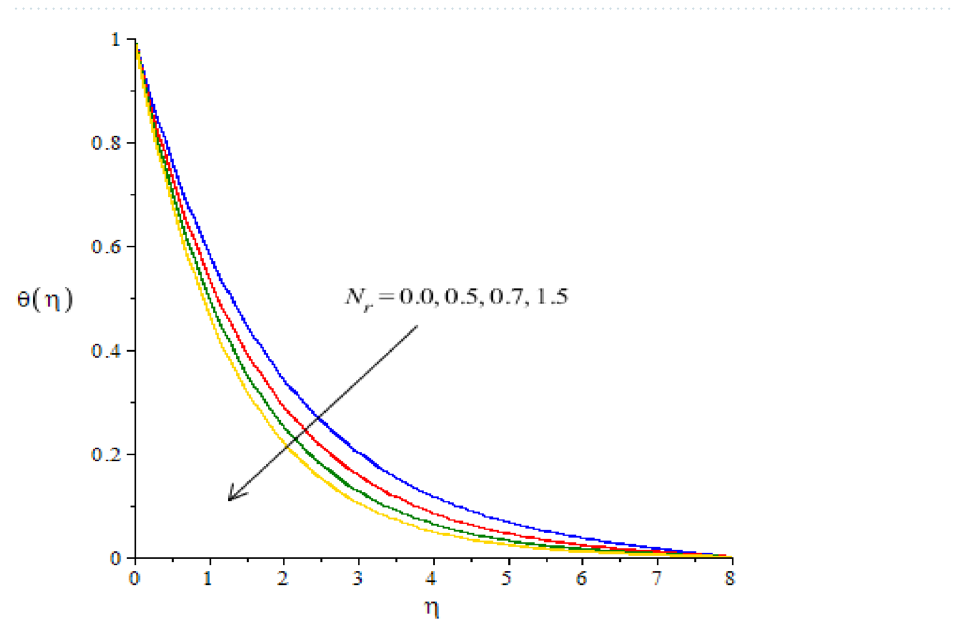
Figure 6. (a,b) The graphical view of velocities versus F r .